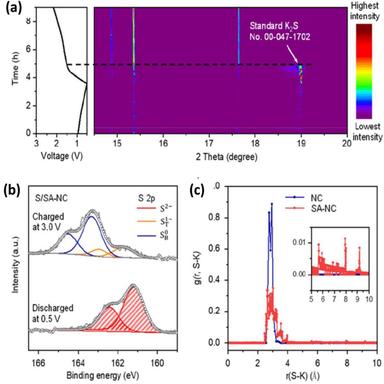
a) In-situ synchrotron XRD patterns for the S/SA-NC electrode in KeS cells. (b) XPS spectra of S/SA-NC electrode and the c) radial distribution function of the SeK bond length calculated by ab initio molecular dynamics. Reprinted (adapted) with permission from Ref. . Copyright 2021 American Chemical Society.